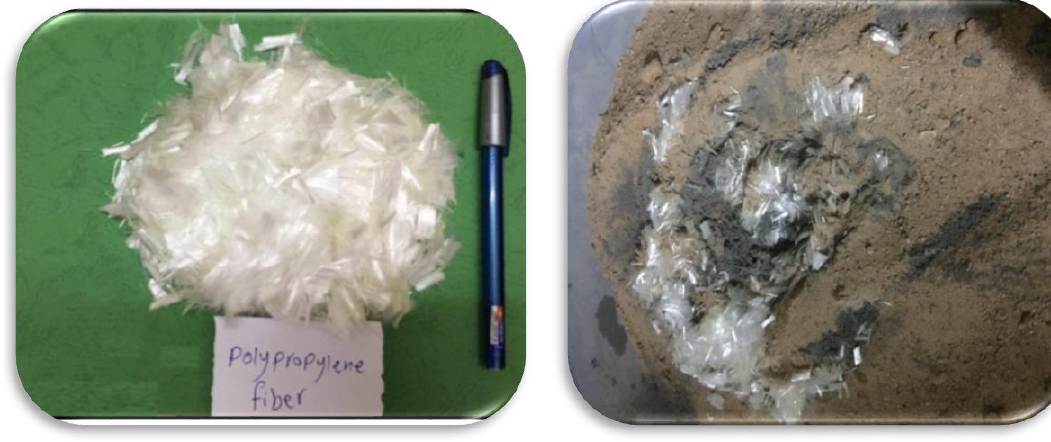
Fig. 2. Polypropylene fiber and cement mixed with soil at its natural water content.